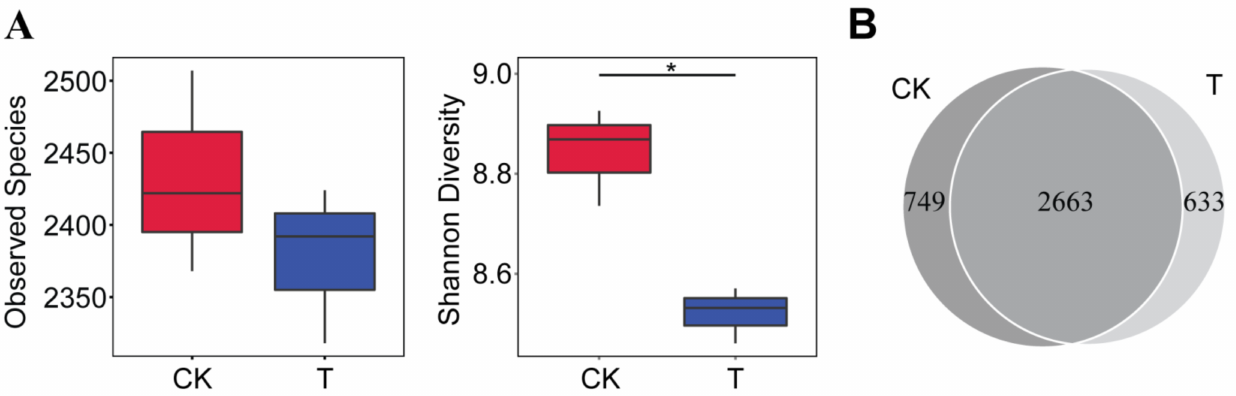
Figure 2. Bioorganic fertilizer alters bacterial community alpha diversity. ( A ) Alpha diversity of rhizosphere bacterial community in the bioorganic fertilizer (T) and no-fertilizer (CK) treatments. Whiskers in the red and blue box represent the range of minimum and maximum alpha diversity values within a control (CK) and bioorganic fertilizer (T) treatment.The bacterial diversity values were considered significantly different between treatments when the p -value < 0.05 (* p < 0.05). ( B )